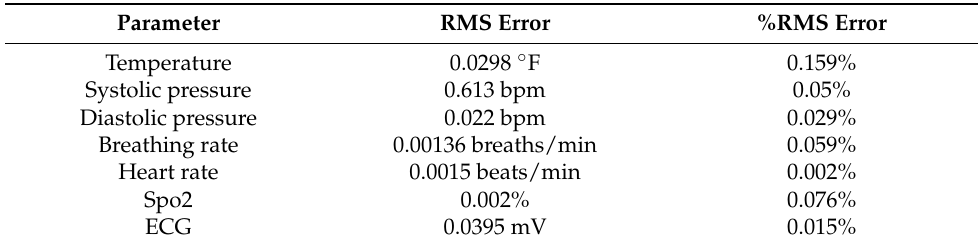
Table 3. RMS errors for various parameters obtained by the LI-Care system.